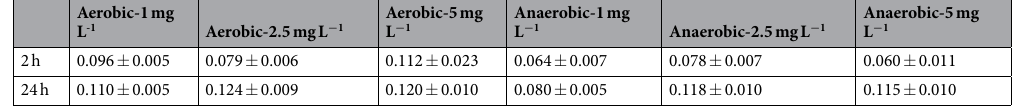
Table 1. Comparisons of leaching Ag + (mg L -1 ) under aerobic versus anaerobic conditions based on ICP-MS